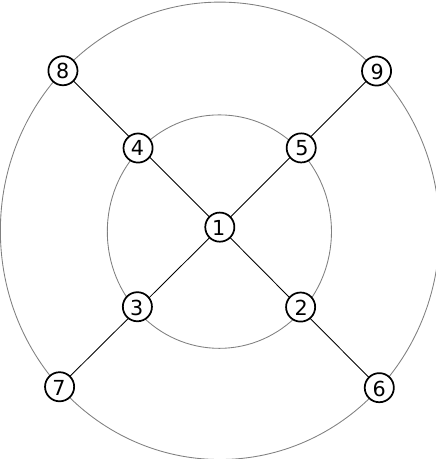
Figure 5. Cooja network topology: four CoAP(s) servers (6, 7, 8, 9) are located two hops away from the IPv6 Routing Protocol for Low-power and Lossy Networks (RPL) border